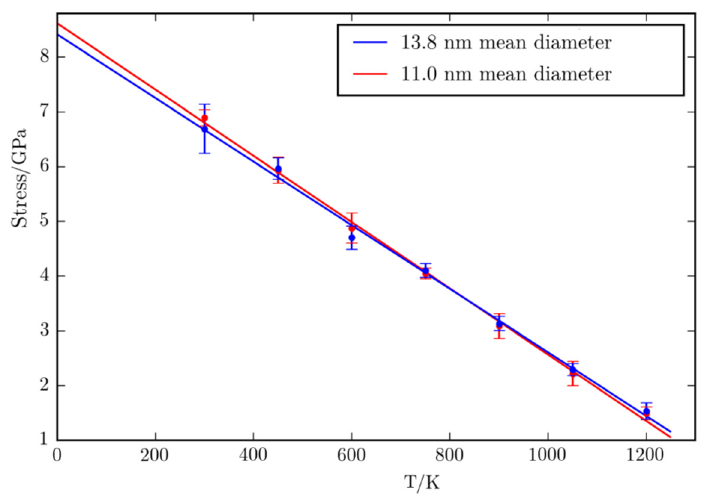
Figure 5. The dependence of critical stress with temperature.